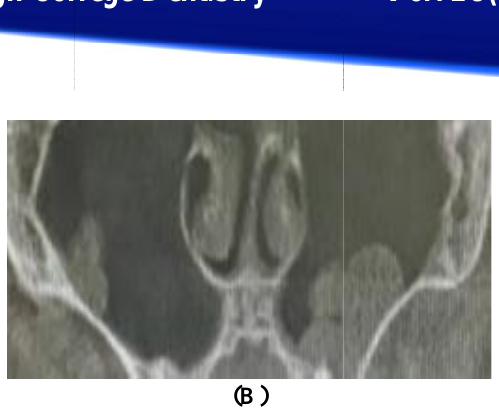
Figure 4: (A) Axial and (B) Coronal View Represent Bilateral Maxillary Sinus Adenoid